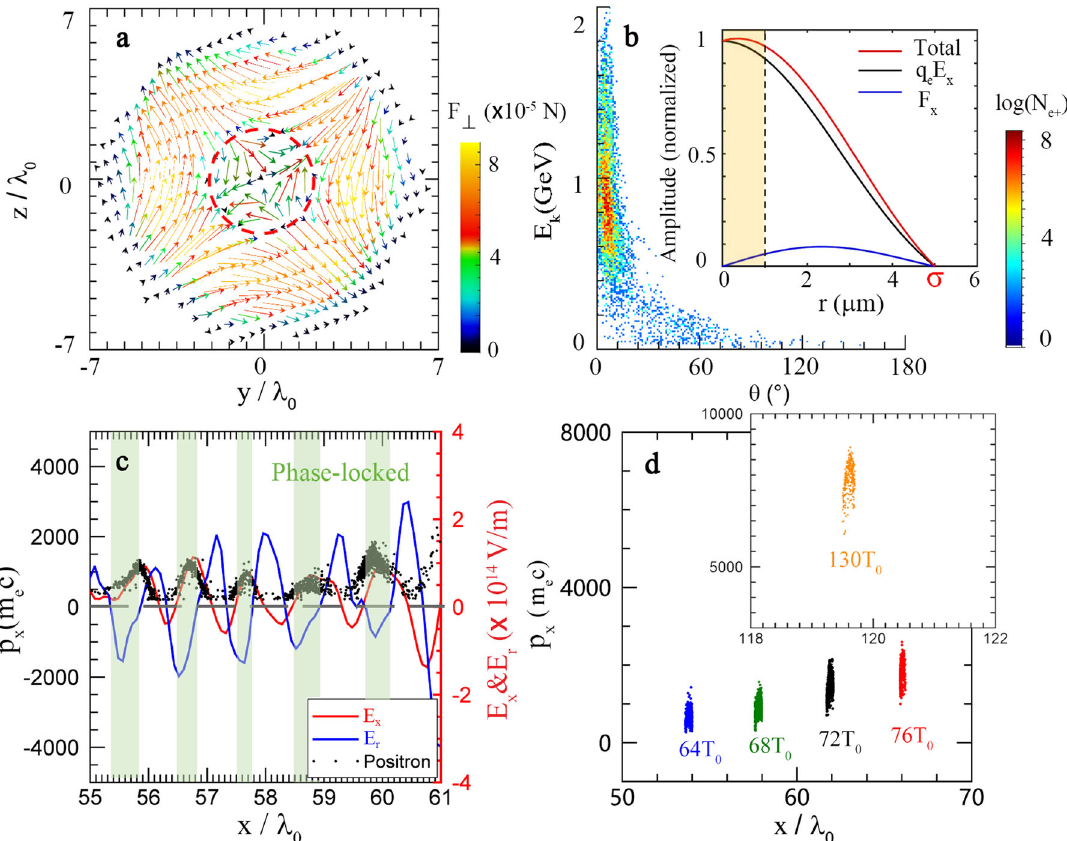
Fig. 5 Phase space distribution of positrons. a Transverse electric and magnetic fi eld force experienced by typical positrons located at x = 68 μ m in the ffiffiffi p y − z plane at t = 65 T r ¼ σ = 2 indicates the location of the positron bunch. b Angle-energy distribution of positrons. The inset 0 . The red dashed circle with shows the magnitude of the longitudinal electric force E x q and the ponderomotive force F x versus r . c Positron distribution in x − p x phase space at t = 70 T 0 . Here, the green shadow indicates the location of positrons phase-locked and accelerated ( E x > 0, E r < 0). d Evolution of the fi rst positron bunch in x − px phase